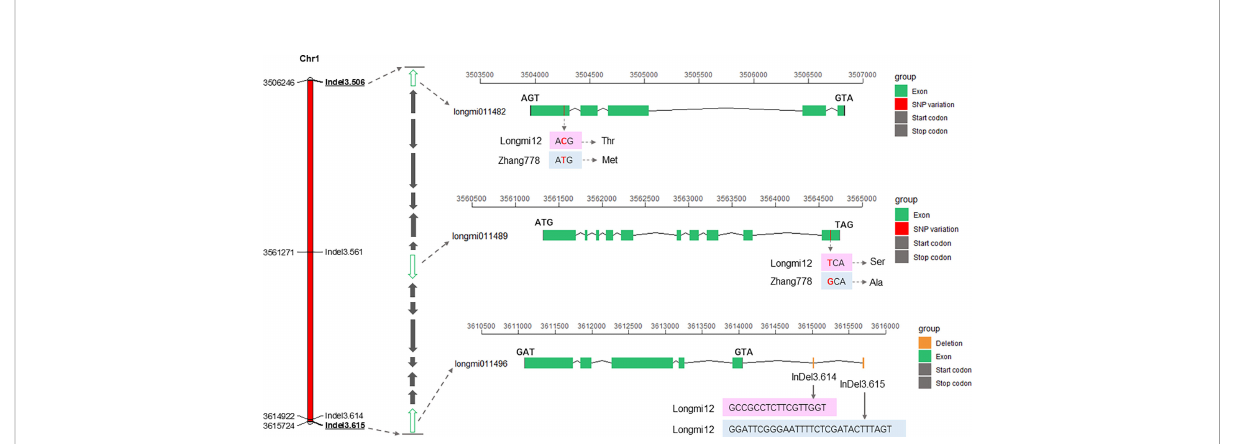
FIGURE 4 Fine-mapping interval of PH1.1 and putative candidate genes within the interval. The left bar is the physical map of the fi ne-mapping interval. The middle arrow diagram shows the genes in the con fi dence interval of PH1.1 , in which green indicates the genes longmi011482 , longmi011489 , and longmi011496 , which contained nonsynonymous variation in their coding region and multiple base insertions or deletions in thepromoterregion. The rightsection displaysthe variationsitesof longmi011482 , longmi011489 ,and longmi011496 betweenLongmi12andZhang778.